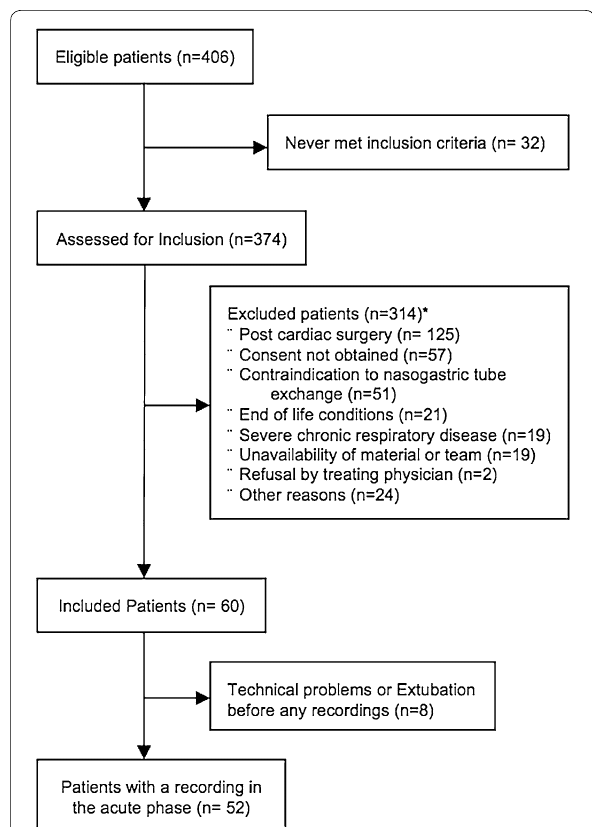
Fig. 1 Study flowchart (*patients could be excluded for two